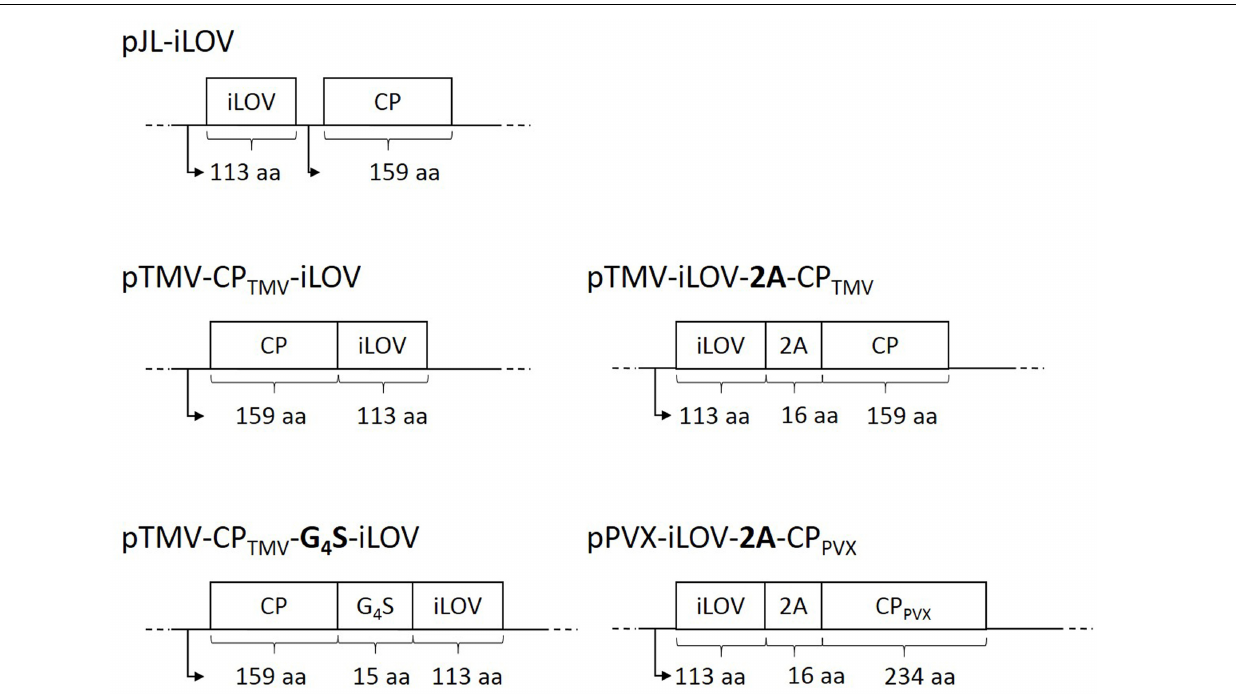
FIGURE 1 | Schematic overview of TMV- and PVX-derived vectors for the expression of iLOV. The target genes are depicted as part of the full viral genomes. The iLOV sequence was added either as a direct fusion or with an intervening (G 4 S) 3 linker to the 3 (cid:48) end of the TMV CP gene. The iLOV gene was also fused via the FMDV 2A sequence to the 5 (cid:48) end of the TMV CP and was expressed as a free polypeptide under the control of a subgenomic promoter (arrows). The pPVX-iLOV-2A-CP PVX vector was generated by fusing the iLOV sequence via the FMDV 2A sequence to the 5 (cid:48) end of the PVX CP gene. Abbreviation: aa = length of amino acid